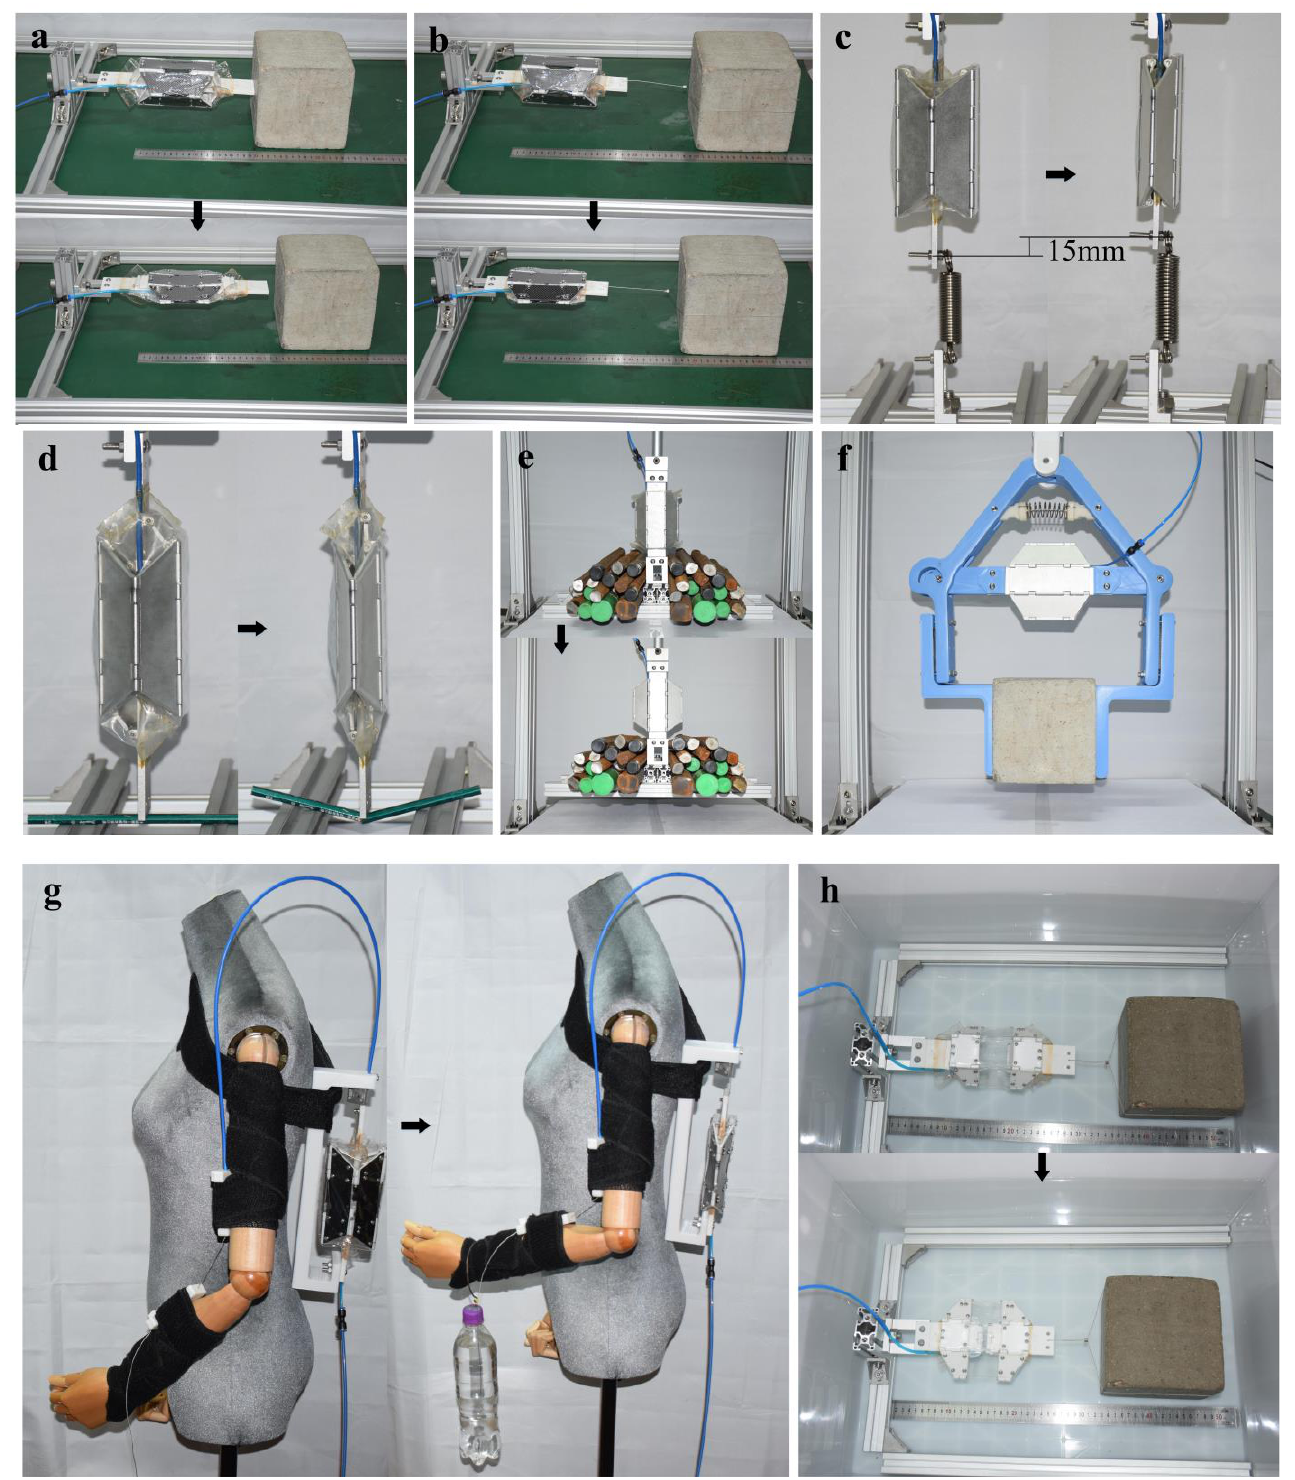
Figure 12. Demonstration of the use of our actuators: ( a ) The CFP-beamed actuator pushes and ( b ) pulls a concrete block (8.1 kg); ( c ) The actuator with a machined skeleton pulls a spring, and ( d ) punches a pencil to break; ( e ) The actuator with a machined skeleton lifts rebars at a total weight of 60.5 kg; ( f ) A clamping gripper clamps a concrete block; ( g ) The CFP-beamed actuator assists the movement of the model’s arm ; ( h ) The PET-beamed actuator moves in the water.